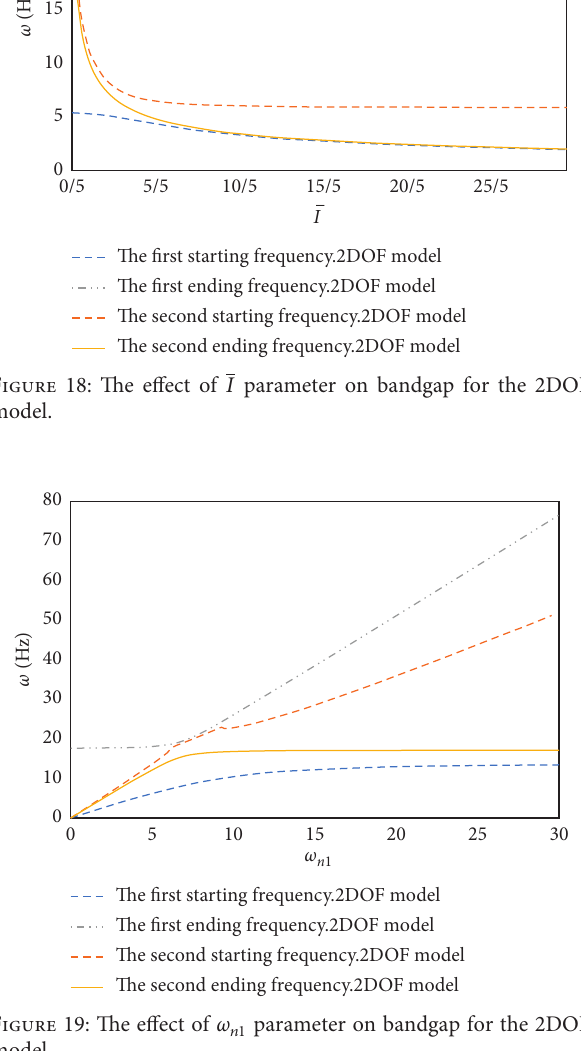
Figure 19: The effect of ω n 1 parameter on bandgap for the 2DOF model.